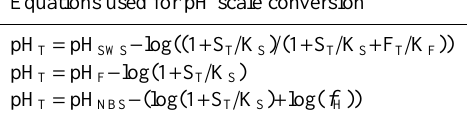
Table 2. Equations used by CO2SYS matlab software routines for conversion on pH scales. The routines use Total Scale internally for CO 2